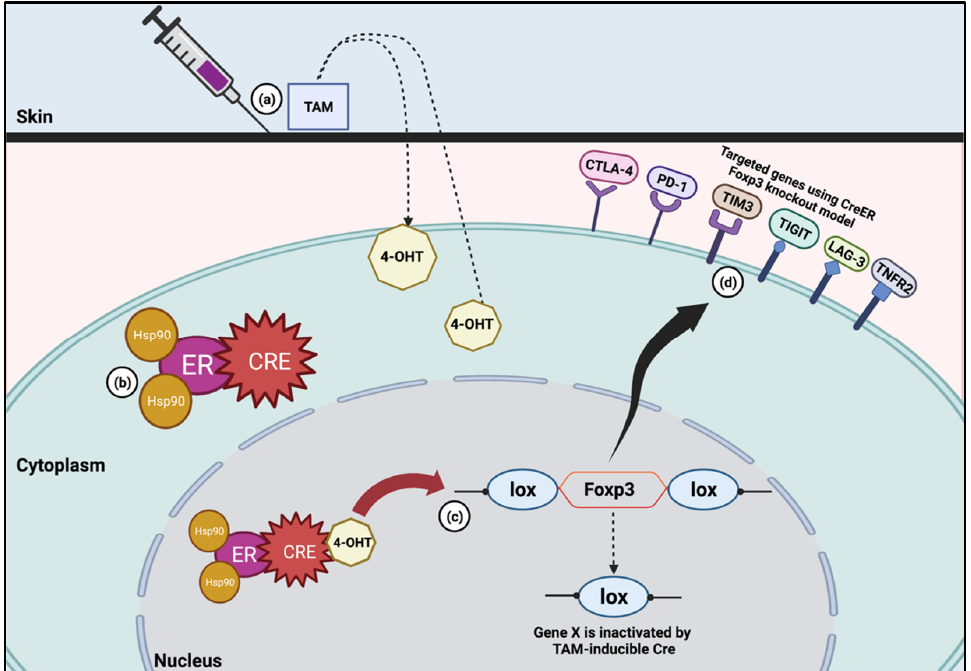
Figure 1. TAM-inducible CreER system in Foxp3 knockout model. ( a ) Once TAM is administered, it is metabolized into 4-hydroxytamoxifen (4-OHT). ( b ) Without TAM, CreER will result in the shuttling of the mutated recombinase into the cytoplasm. The protein will stay in this location in its inactivated state until TAM is given. ( c ) 4-OHT then binds to the ER and results in the translocation of the CreER into the nucleus, where it is then able to cleave the lox sites. ( d ) Foxp3 knockout model has been